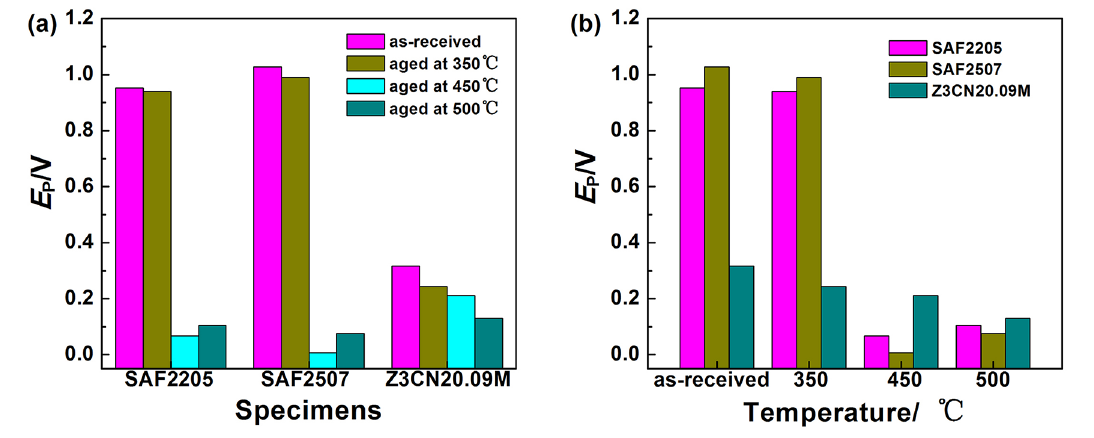
Figure 6. Pitting potential of (a) different thermally aged DSS specimens and (b) different thermal aging